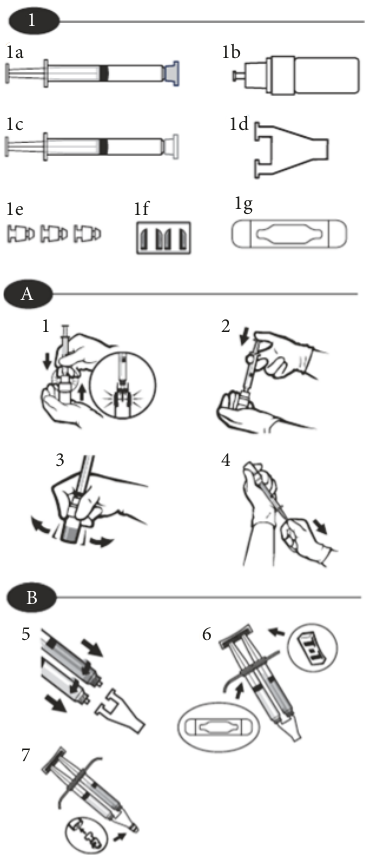
Figure 1: Schematic of DuraSeal dural sealant system assembly. Note . Omit step 7 as the spray tip is not needed for percutaneous injection of the hydrogel sealant. Instead attach the applicator directly to the Tuohy needle hub using the Luer lock mechanism.